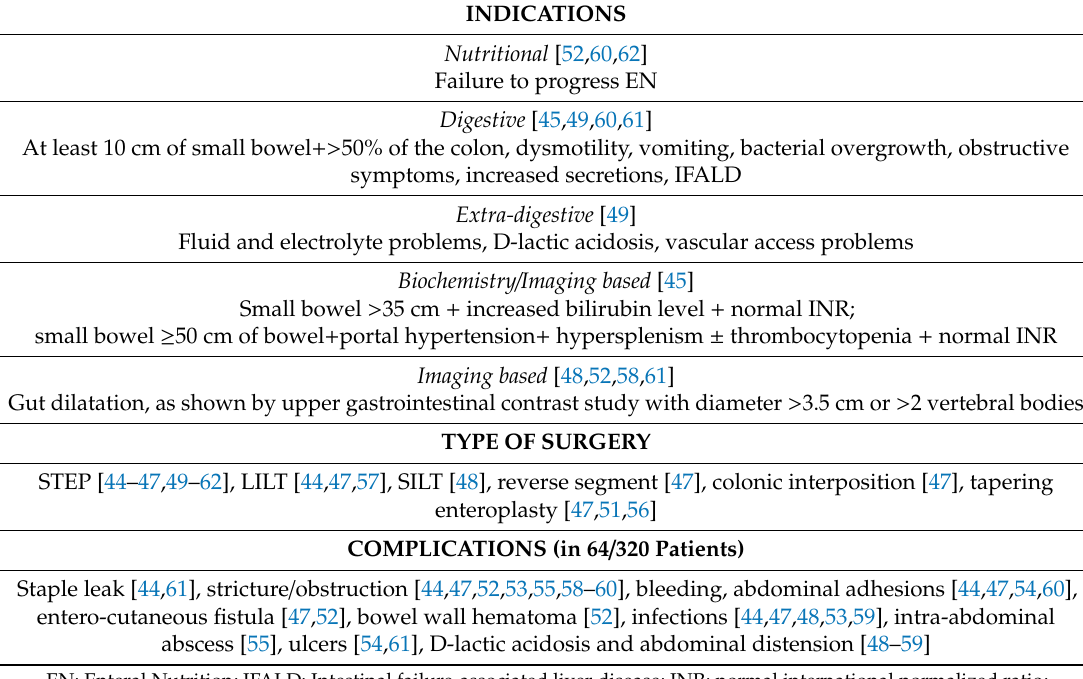
Table 3. Indications, types of surgery and complications [Ref. n ◦